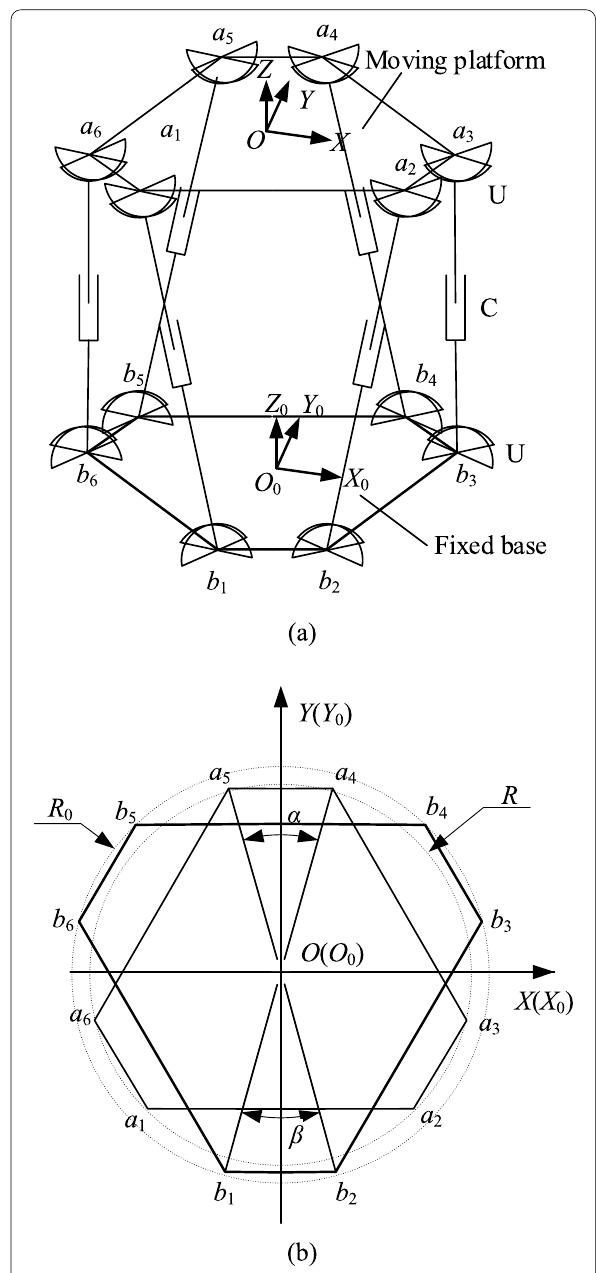
Figure 7 Coordinate and setting of the 6-UCU parallel mechanism: a Kinematic diagram, b Distribution map of